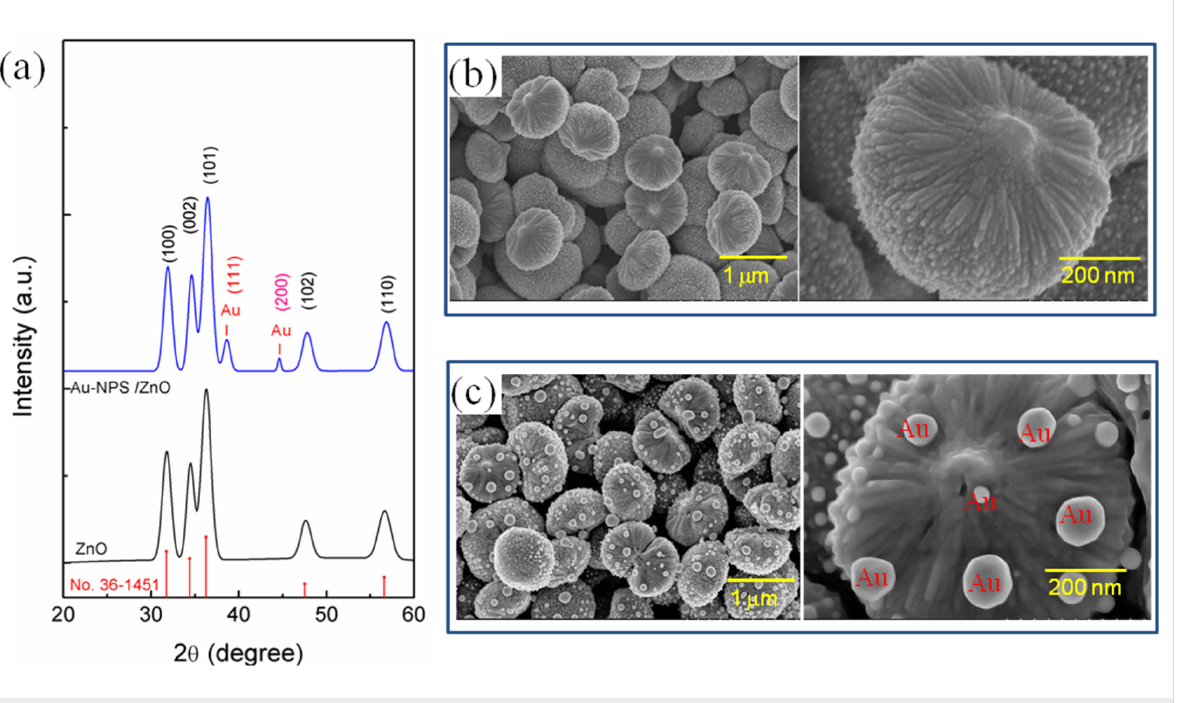
Figure 1: XRD patterns (a), FE-SEM images of as-deposited ZnO and Au nanoparticle/ZnO structures using the chemical bath deposition approach (b and c).